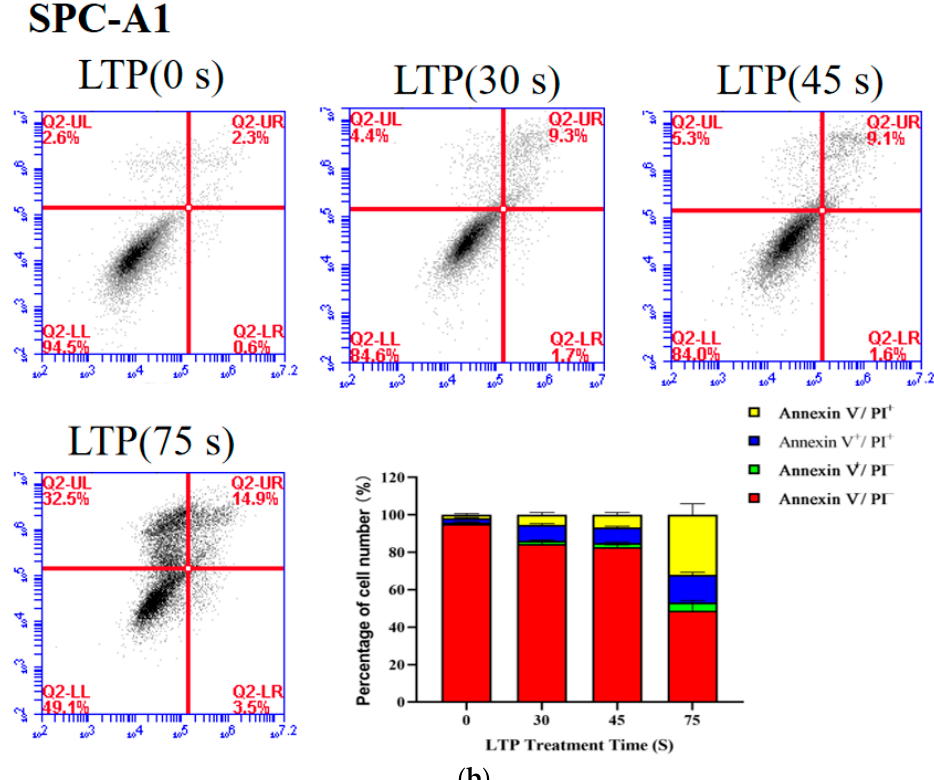
Figure 4. LTP induced the death of CALU-1 and SPC-A1 cells. Flow cytometry was performed to analyze cell death by PI and Annexin V-FITC staining in ( a ) CALU-1 and ( b ) SPC-A1 cell lines after LTP treatment for 30, 45, and 75 s, and measured after 24 h.